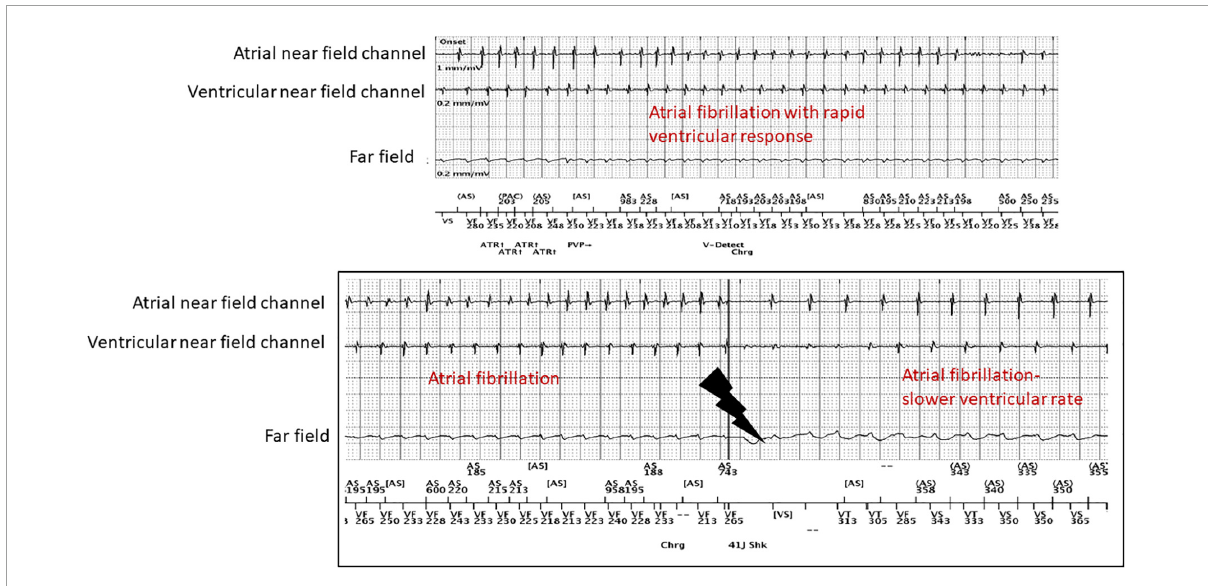
FIGURE4 Patient with atrial fibrillation with rapid ventricular response with an inappropriate shock after stopping his beta-blocker due to concerns for erectile